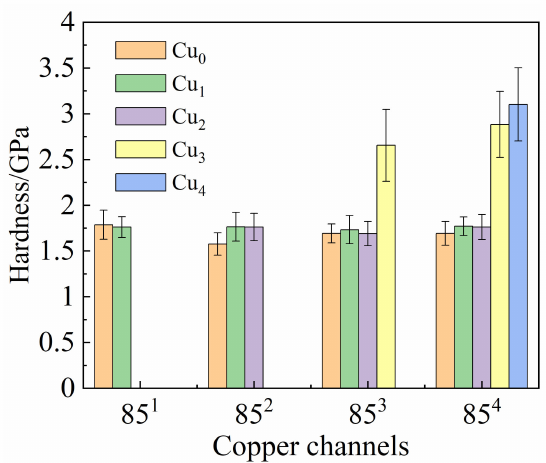
Figure 5. Nanohardness data of copper channels in different Cu-Nb